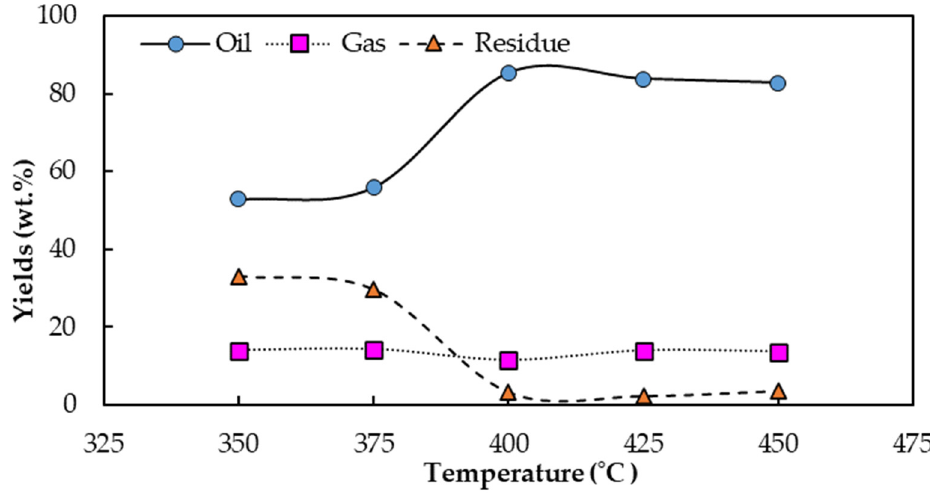
Figure 6. The influence of reaction temperature on product yields. (Operating conditions: a flow rate of N 2 of 40 mL/L, an AC:WCO mass ratio of 1:40 and a pyrolyzed temperature range of 350–450 °C.)